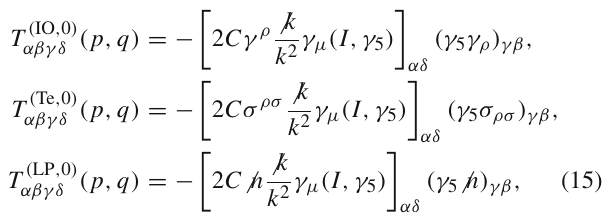
where the superscript (0) indicates the tree-level approxima- ( i = 1 . 2 ) are the energies of the u − and d − quarks, tion, ω (cid:4) i the Lorenz index μ is not shown exactly, and α, β, γ, δ are the Dirac